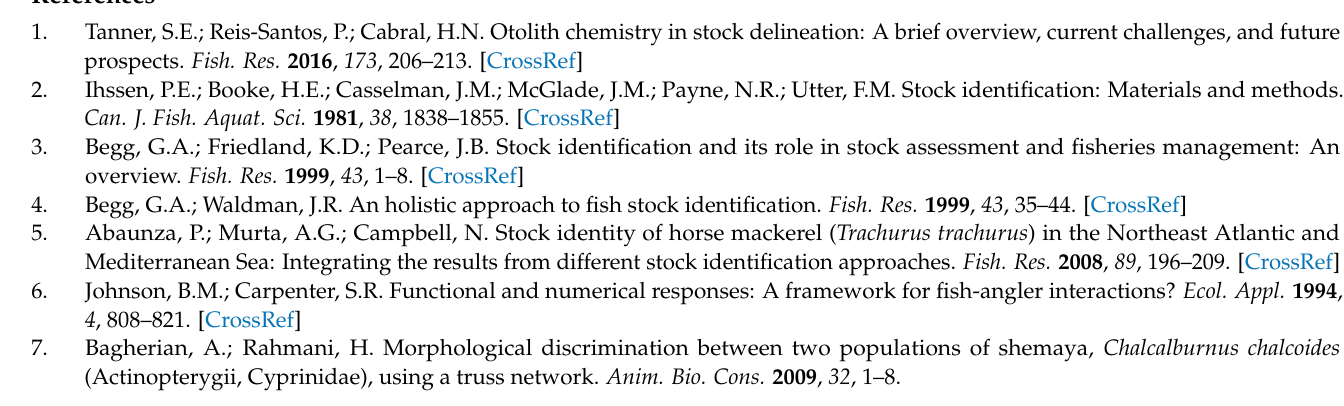
Figure S3: Scree plot of principal component in morphometric measurements for Botia dario in five rivers of Bangladesh. Table S1: MANCOVA tests for effect of sampling sites, total length (TL) (co- variate) and their interaction of body morphology of Botia Dario. Table S2: Univariate ANOVA of morphometric lengths and their ratios of Botia dario stocks collected from the five rivers of Bangladesh. Table S3: Factors loading of different morphometric measurements and their ratios by using PCA among different stocks of Botia dario collected from the five rivers of Bangladesh. Table S4: Wilk’s lambda test for verifying differences among stocks of Botia dario with morphometric measurements and ratios, using canonical variate analysis (CVA). Table S5 Contribution of morphometric measure- ments and ratios to the canonical variate scores in Botia dario collected from five rivers in Bangladesh. Table S6: Classification of Botia dario into their original stocks using classification matrix (original and cross-validated) of the CVA based on morphometric measurements and ratios. Table S7: Univariate ANOVA of morphometric lengths and their ratios of Botia dario stocks collected from the five rivers of Bangladesh. Table S8: Factors loading of truss measurements using PCA among different stocks of Botia dario collected from the five rivers of Bangladesh. Table S9: Wilk’s lambda test for verifying differences among stocks of Botia dario with truss measurements using canonical variate analysis (CVA). Table S10: Contribution of truss measurements to the canonical variate scores in Botia dario col- lected from five rivers in Bangladesh. Table S11: Classification of Botia dario into their original stocks using classification matrix (original and cross-validated) of the CVA, based on truss